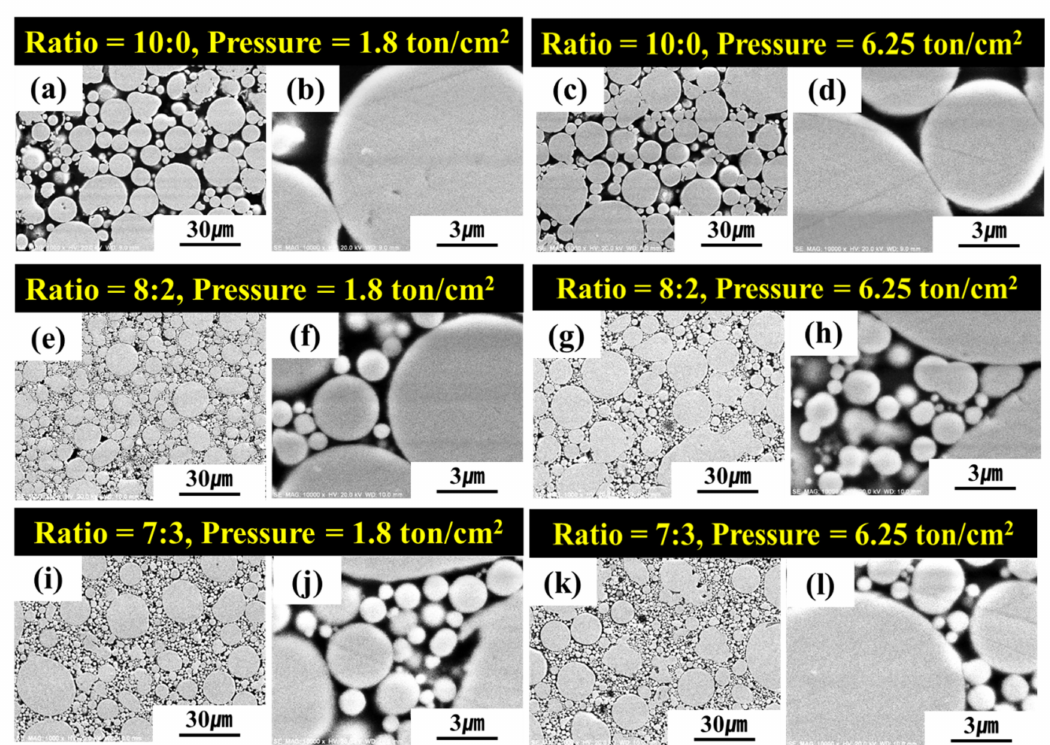
Figure 4. SEM images of various bulk composites fabracated by di ff erent molding pressure. The mixing ratios of the Fe-6.5 wt.% Si powder and fine iron powder were (a,b) 10:0, 1.8ton / cm 2 , (c,d) 10:0,